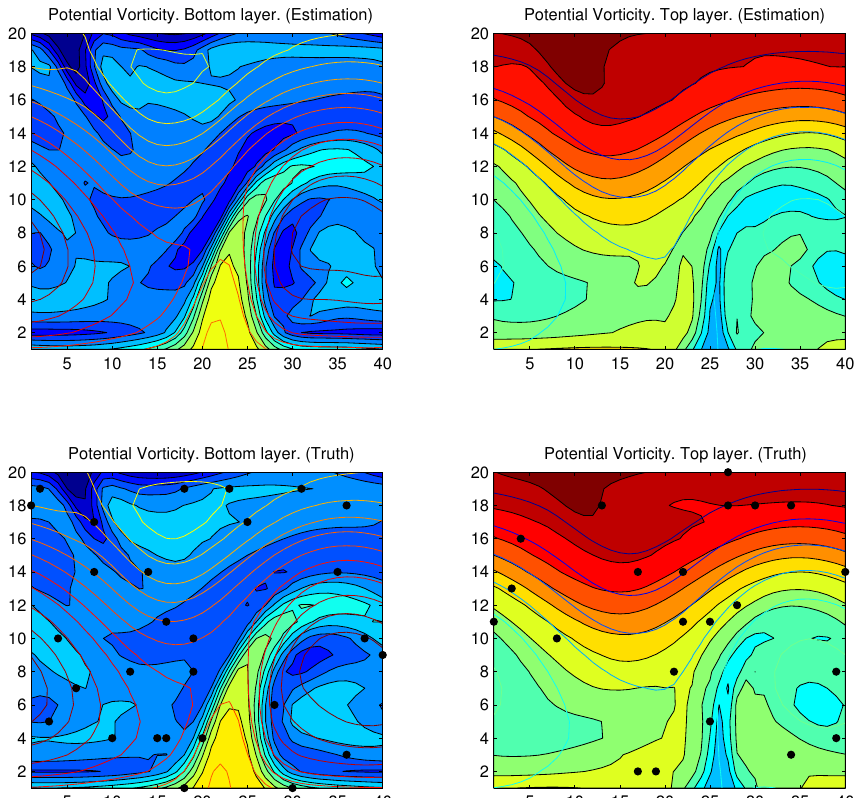
Figure 2. The true state (top-row panels) and the EKF estimate (bottom-row panels) for the bottom layer (left-column panels) and for the top layer (right-column panels) in a 20 × 40 grid for each layer using 50 randomly chosen observation locations (black dots). Filled contours describe the potential vorticity, and line contours describe the stream function.